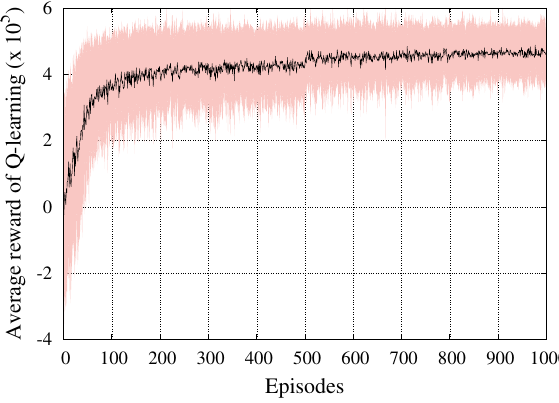
Figure 3. The average reward over episodes using Q-learning with the parameters, α = 0.1, γ =